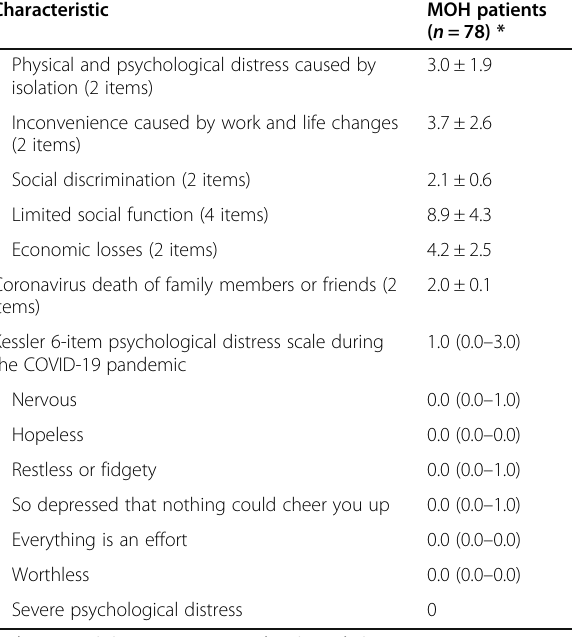
Table 1 Distribution of different variables in MOH patients